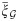
Decision boundaries for positive, negative or random mixing in the network.If the average similarity of connected nodes in the network ξ¯G falls in the top 2.5% quantile of f(ξ¯rand) (e.g., green line) we can conclude—at the significance level of α = 0.05—that the network is positively mixed. Similarly, if ξ¯G falls in the bottom 2.5% quantile of f(ξ¯rand) (e.g., red line) the network is negatively mixed. Otherwise (e.g., orange line) we cannot reject the hypothesis that the network is randomly mixed with respect to x.